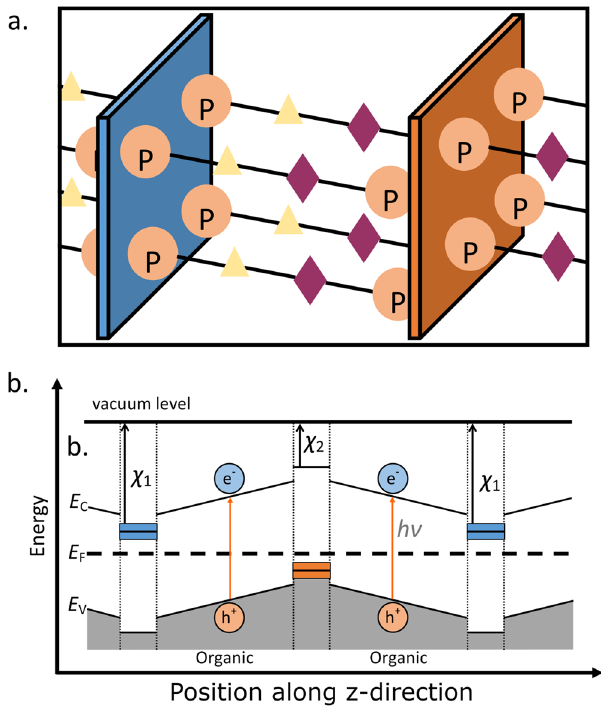
Figure 1. ( a ) Schematic of the proposed atomic structure, in which alternating inorganic hole and electron transport layers (blue and orange sheets, respectively) are separated by polar organic absorber molecules. Triangles and diamonds represent organic functional groups chosen to tune the polarization and the band alignment. ( b ) Schematic band energy diagram corresponding to the structure in ( a ). χ 1 and χ 2 are the electron affinities of the inorganic electron and hole conducting layers,